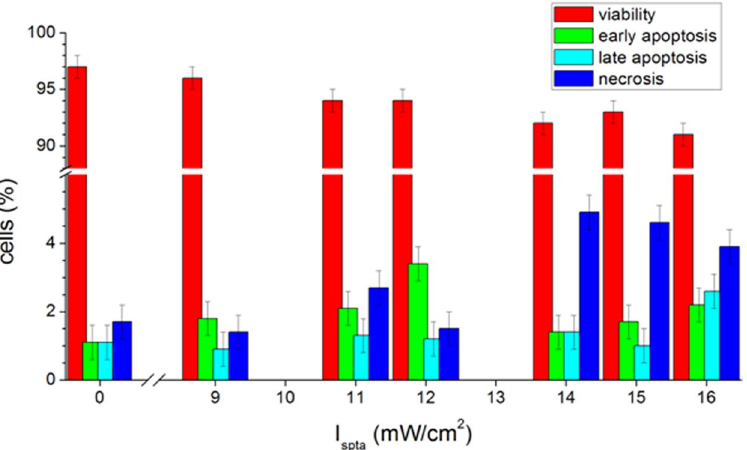
Figure 6. Viability and apoptosis vs necrosis evaluated by flow cytometry using a combined AnnexinV and PI assay on HaCaT cells sonicated for 15 ′ at 1 MHz, for different values of the I spta .